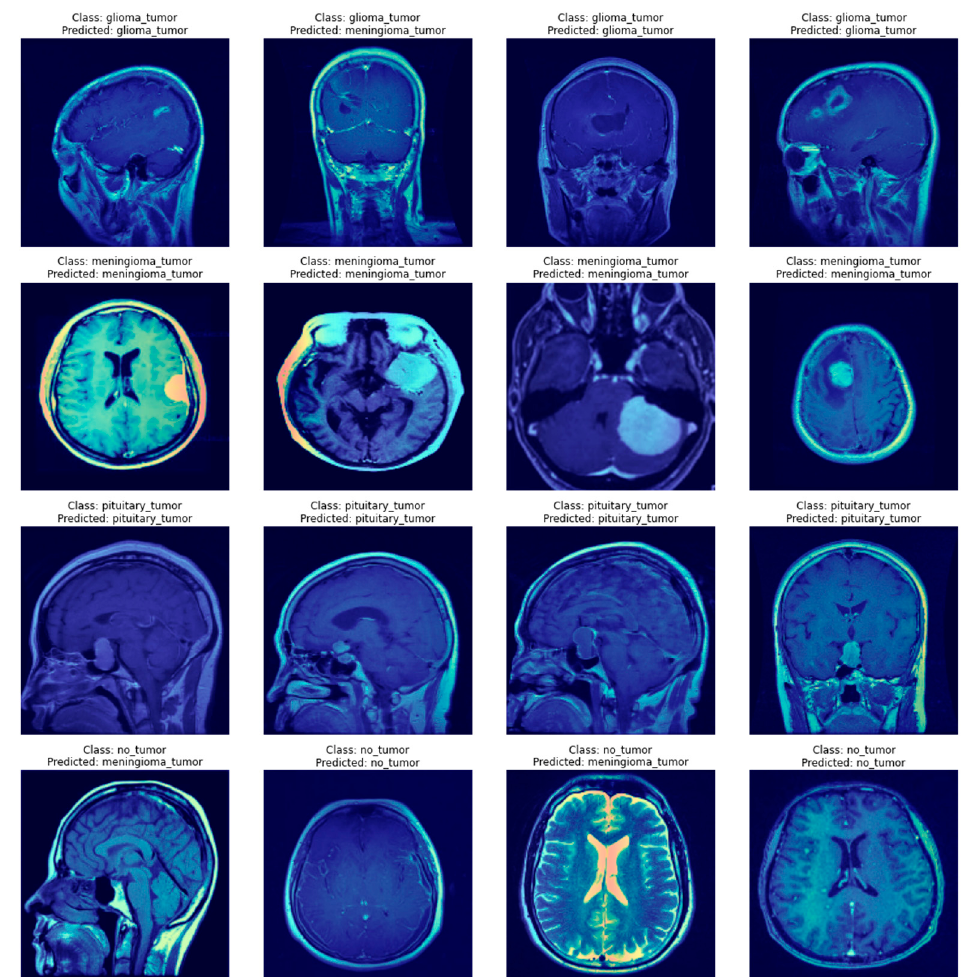
Figure 7. A few examples of Attention Rollout produces heatmaps for the simple ViT’s